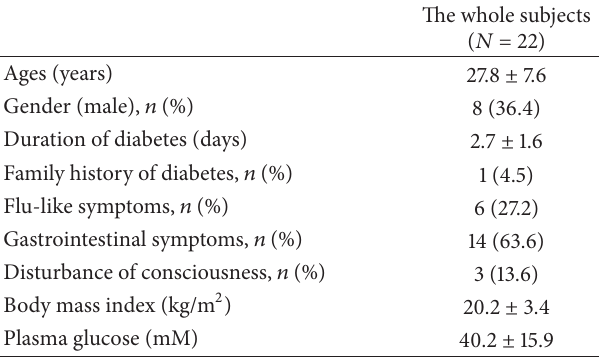
Table3:Distributionofserumantibodyandspecific-reactiveTcells in 10 Chinese FT1D patients.